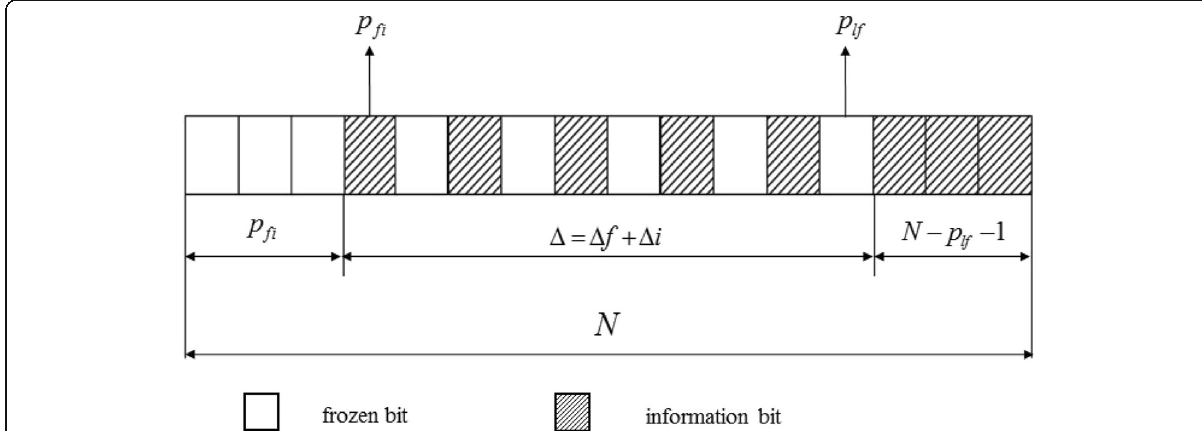
Fig. 7 The information bits and frozen bits distribution at N = 16: For the non-hybrid area, the index value of p fi represents the number of the frozen bits, and N − p lf − 1 represents the number of the information bits, where N has been defined as the code length previously. The value of N is the total number of all frozen bits and information bits. The width of the hybrid area in the generator matrix can be represented by Δ =p lf − p fi + 1. The value of Δ also represents the sum of the frozen bits and the information bits in this hybrid area. These defined variables of p length N is